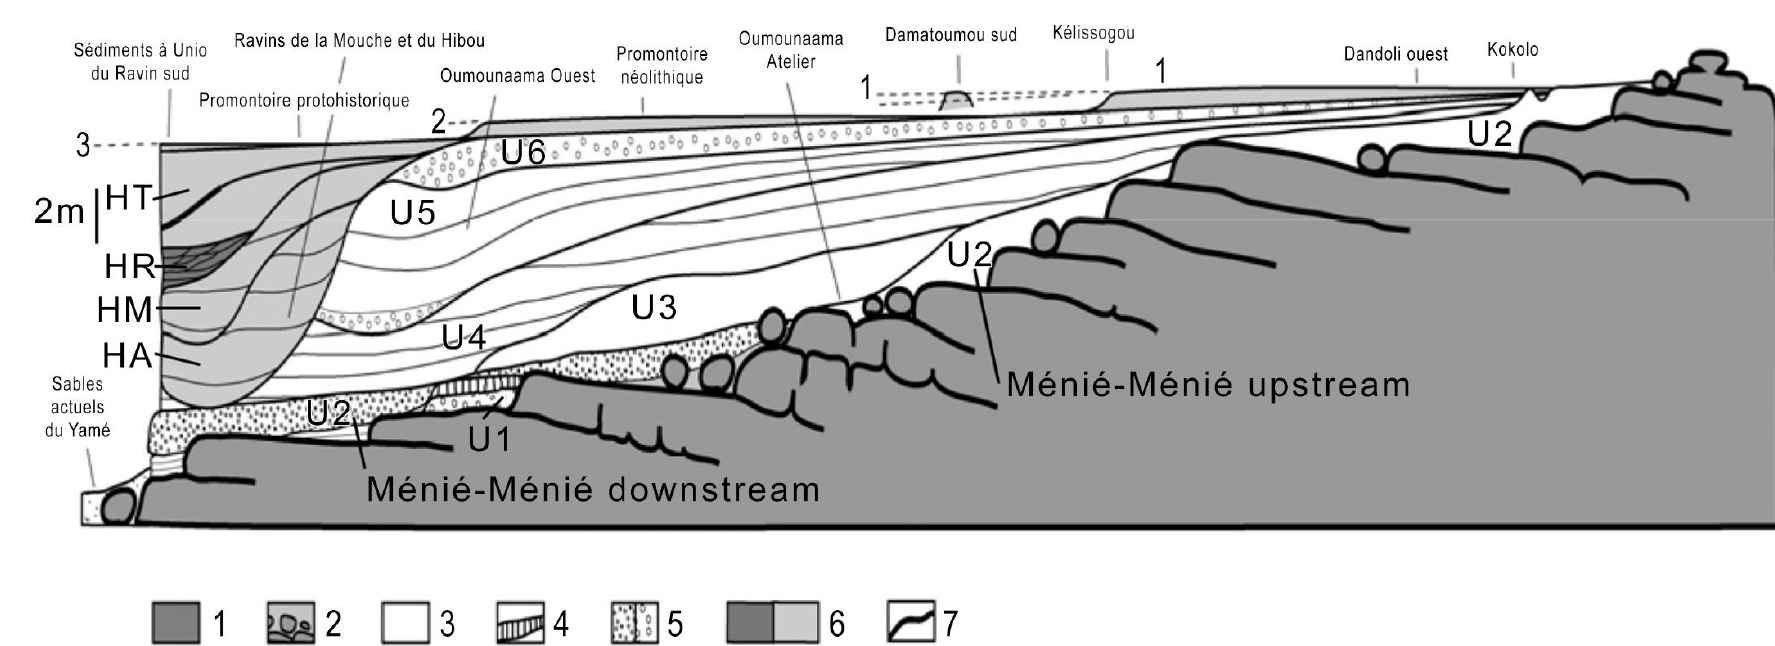
Figure 2. Synthetic profile of Ounjougou stratigraphic sequence (modified from Rasse et al. 2004). 1. Sandstone; 2. Arenaceous sandstone; 3. Pleistocene formations; 4. Iron duricrust; 5. Coarsed alluvial deposits; 6. Holocene formations. Abbreviations: HA - Early Holocene; HM - Middle Holocene; HR - Late Holocene; HT - Final Holocene); 7.